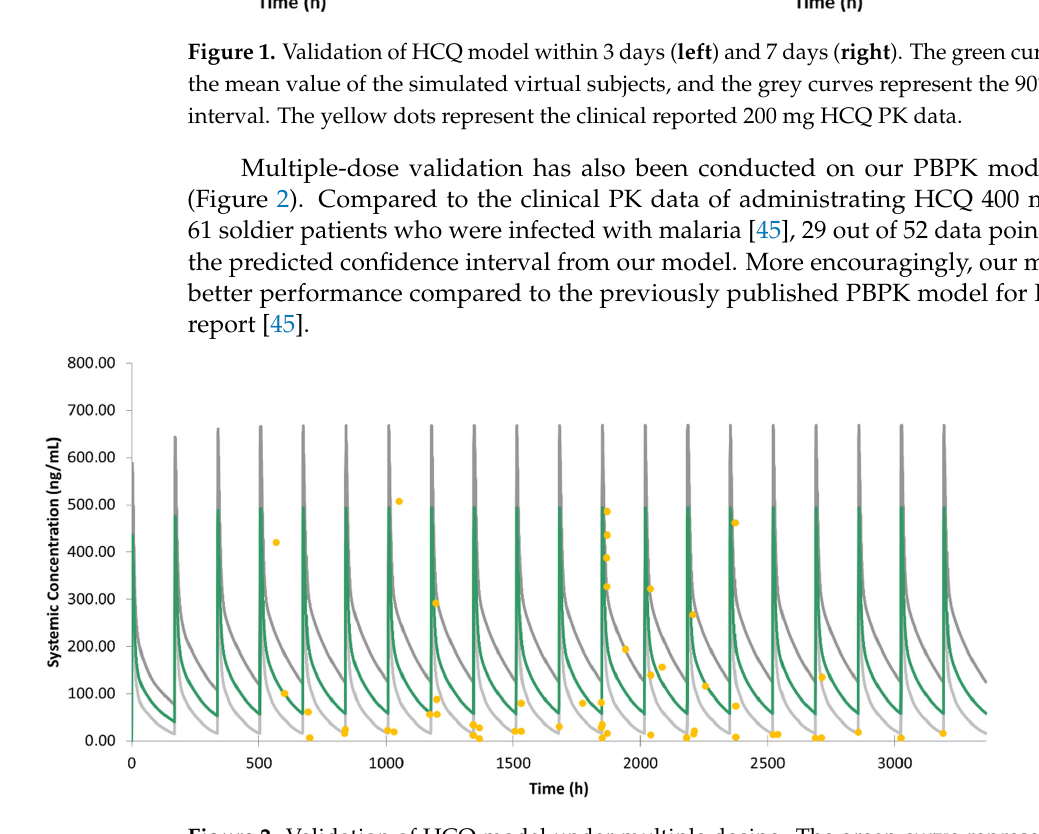
Figure 2. Validation of HCQ model under multiple dosing. The green curve represents the mean value of the simulated virtual subjects, and the grey curves represent the 90% confidence interval. The yellow dots represent the clinical reported PK data of 400 mg HCQ every week.